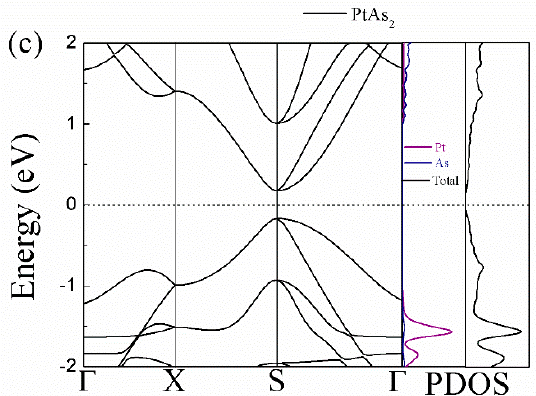
Figure 2. Electronic band structures and projected density of states (PDOS) calculated by HSE06 hybrid functional potentials of monolayer ( a ) NiAs 2 , ( b ) PdAs 2 and ( c ) PtAs 2 . The zero of the energy in the figures is chosen as the middle of the calculated band gap.